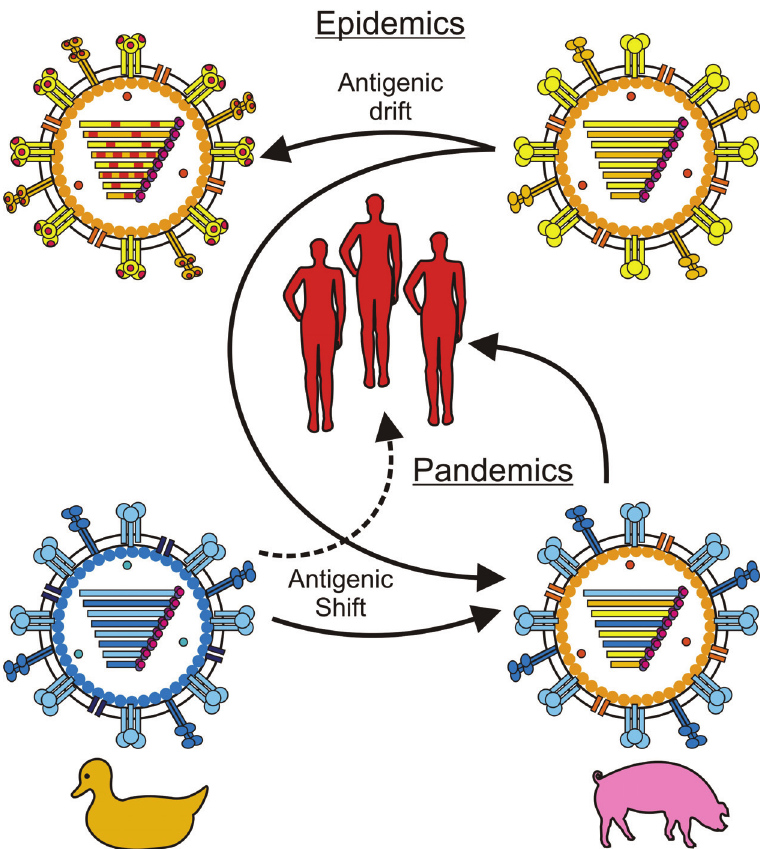
Figure 1. Antigenic drift and shift to escape immunity. The gradual accumulation of mutations, mainly in the highly variable globular head region of HA, causes the influenza virus to escape recognition by virus neutralizing antibodies and allows it to cause seasonal epidemic outbreaks. This phenomenon is called antigenic drift. The introduction of a novel subtype into the human population is called antigenic shift and may cause a pandemic outbreak in the naïve human population when the virus is efficiently transmitted from human to human, since antibodies directed against the novel subtype are absent. Past pandemic outbreaks were caused by exchange (re-assortment) of gene segments between two or more influenza strains, e.g., avian and human. However, recent studies in ferrets suggest that avian influenza viruses, like H5N1, could be directly transmitted from animal reservoirs into the human population, requiring only a small number of adaptive mutations [9] as indicated by the dotted line in this